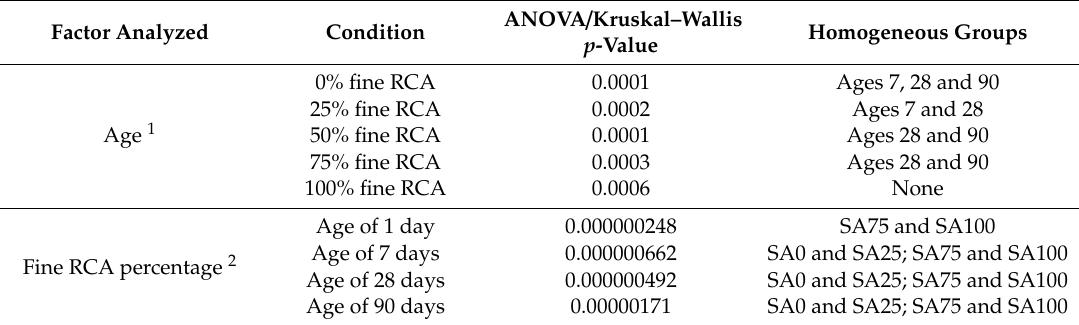
Table 12. Results of ANOVA analysis and Kruskal–Wallis